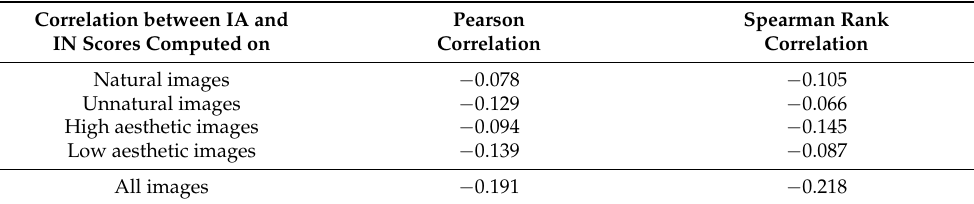
Table 1. The correlation between IA scores and IN